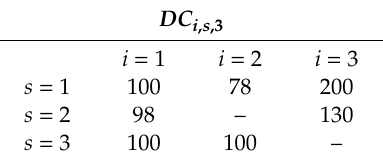
Table A13. Maximum distribution capacity at time period 3 (units).